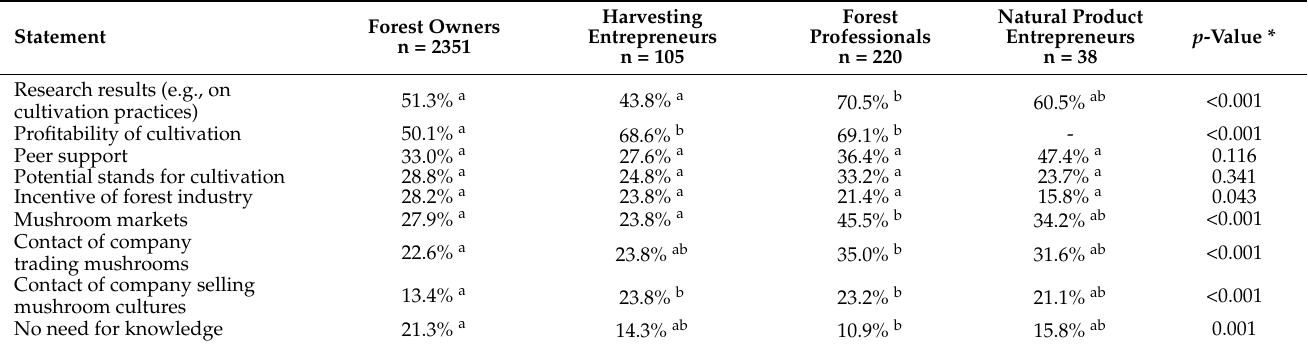
Table 13. Knowledge needed for participating in specialty mushroom cultivation (multi-select